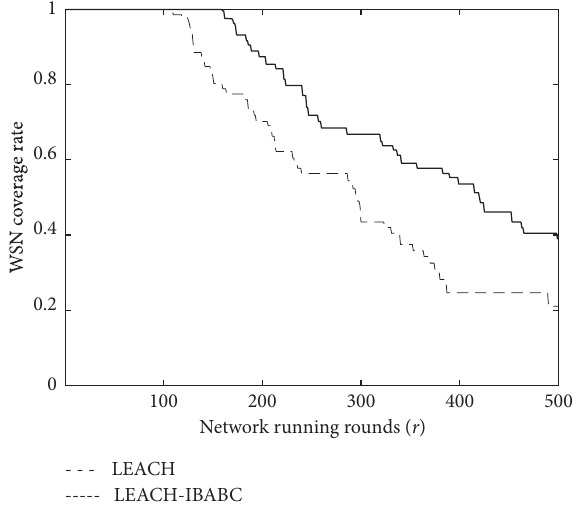
Figure 8: Coverage rate comparison of LEACH and LEACH- IBABC vs the number of running rounds.